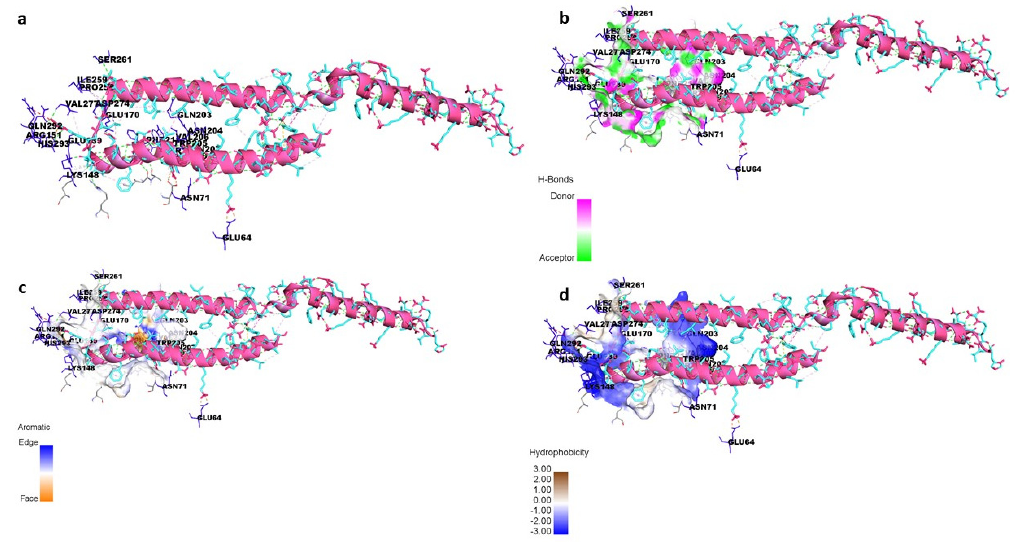
Figure 10. ( a ) Mode of binding of EntA (red) peptide with protein stabilized by non-bonding interactions with amino acid residues. ( b ) Hydrogen-bonding interactions of peptide with protein residues. ( c ) Representation of π – π interaction stabilizing the binding of EntA. ( d ) Hydrophobic cavity supporting peptide binding to protein.